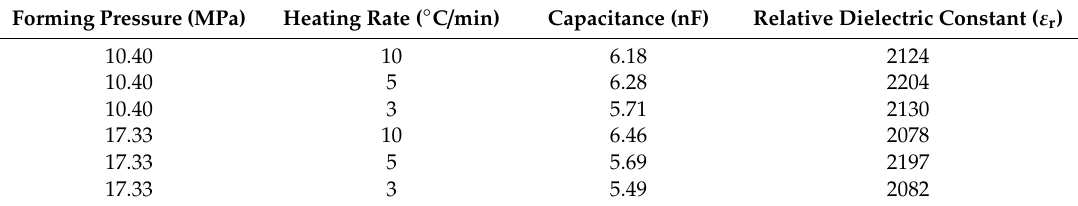
Table 3. Dielectric properties of the ring-type PZT ceramics.